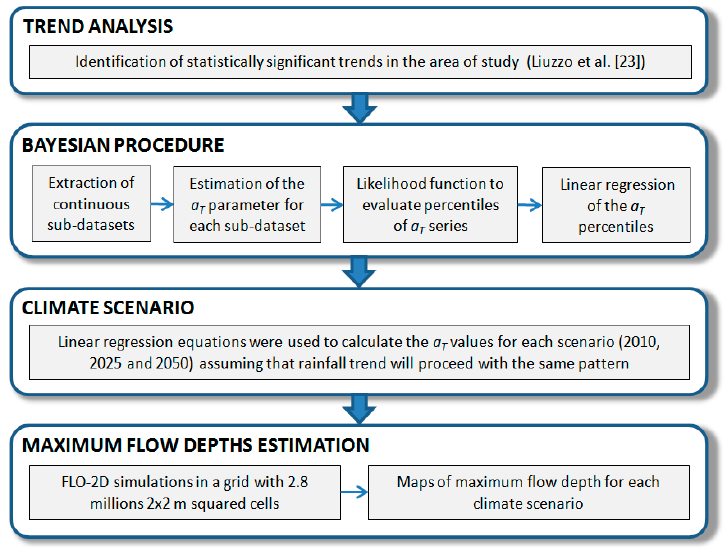
Figure 2. Flow chart of the applied procedure.